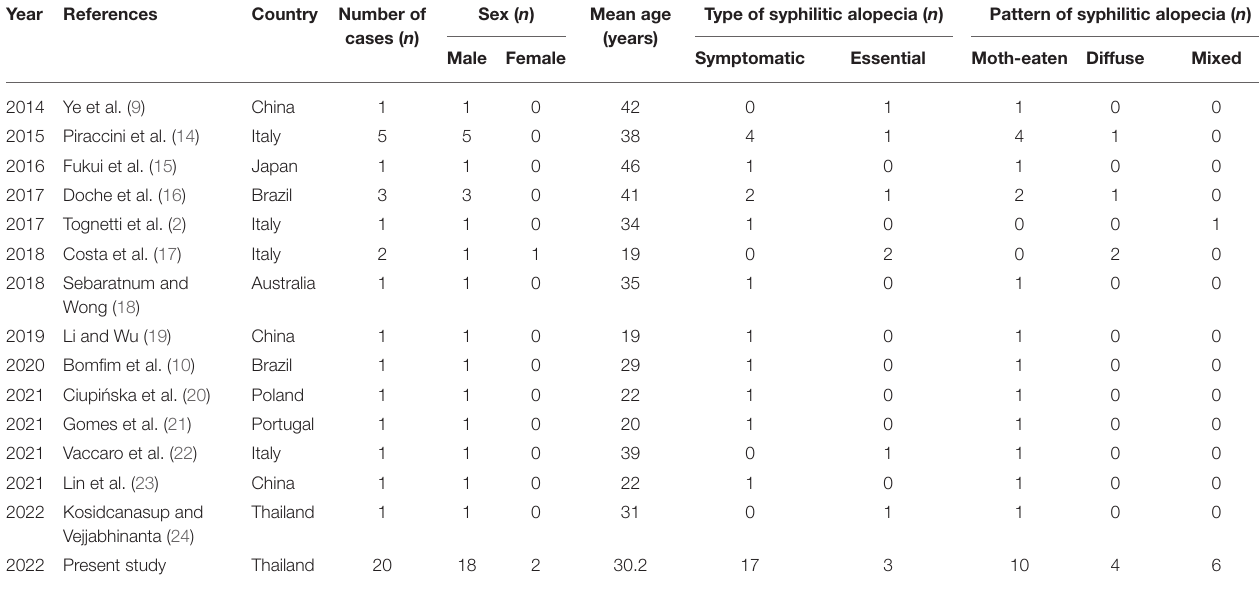
TABLE 3 | Characteristics of studies included in the systematic